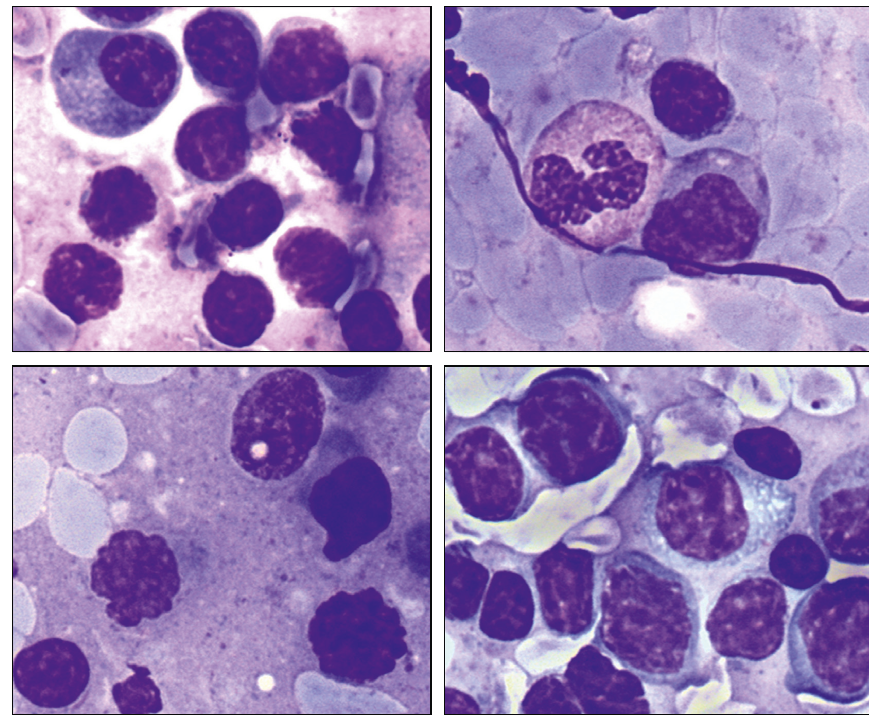
Figure 4: The cytology of the imprint of the submandibular salivary gland. Two lymphocyte populations can be detected. Some lymphocytes correspond to the characteristics of CLL/SLL lymphocytes. The others have an irregular shape of the nucleus, and some contain cytoplasmic granules. Romanowsky–Giemsa staining, × 1000.